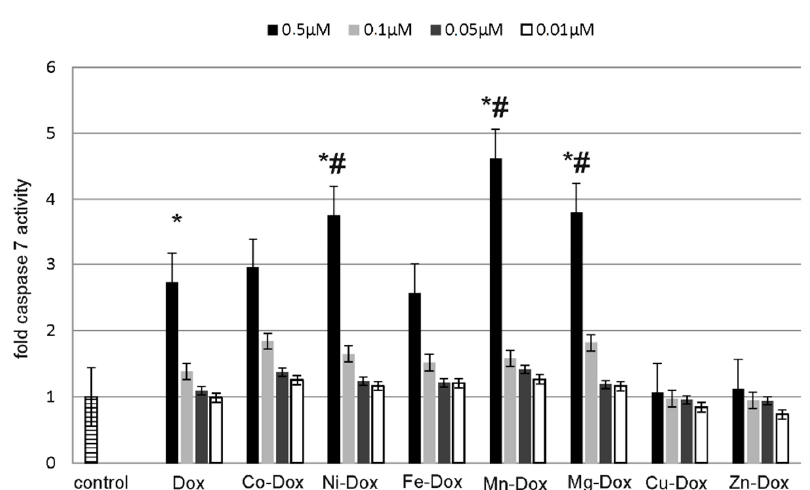
Figure 10. The effect of DOX, Cu-DOX, Zn-DOX, Co-DOX, Ni-DOX, Fe-DOX, Mn-DOX and Mg-DOX on apoptosis in MCF-7 cells. The cells were incubated with 0.5 µM, 0.1 µM, 0.05 µM and 0.01 µM DOX and Metal-DOX complexes for 24 h. Mean values from five independent experiments ± SD are shown. Significant alterations are expressed relative to control untreated cells (marked with asterisks *) and to DOX—controls (marked with crosses #). Statistical significance was considered if *# p < 0.05.